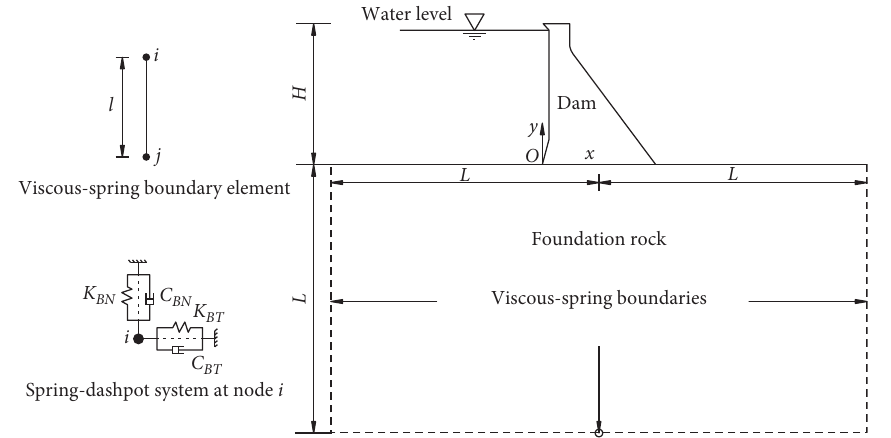
Figure 1: Viscous-spring boundary of the dam-foundation system.